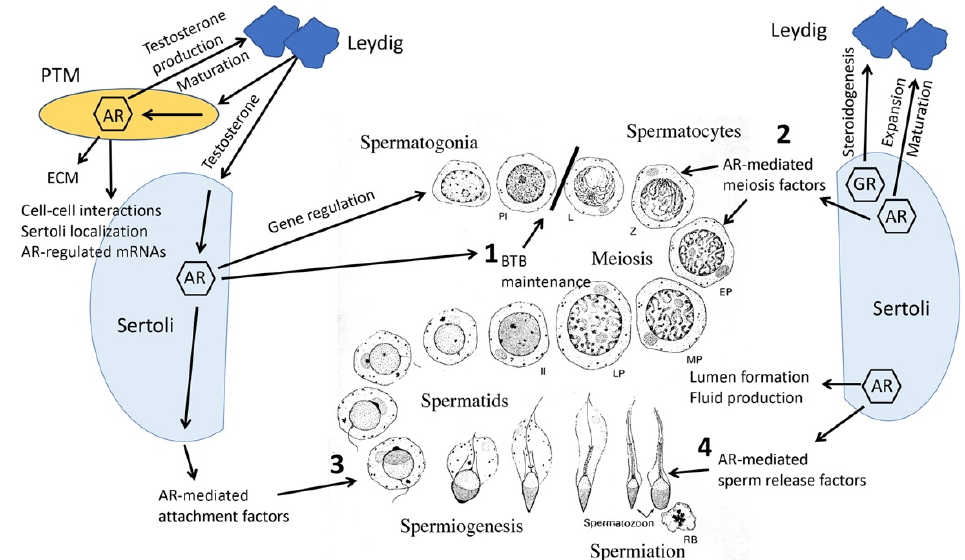
Figure 1. Steroid hormone-mediated signals between testicular cells maintain fertility. Androgen receptor (AR)-mediated actions in Sertoli cells support four major germ cells processes ( 1 – 4 ) required to maintain fertility. AR and glucocorticoid receptor (GR) in Sertoli cells support expansion and maturation of Leydig cells and steroidogenesis. Leydig cells produce testosterone that stimulates AR-mediated processes in Sertoli and peritubular myoid (PTM) cells. AR-dependent actions in PTM cells support the maturation of Leydig cells and their steroidogenesis as well as production of extracellular matrix (ECM), cell–cell interactions, Sertoli localization (positioning on the basement membrane) and AR-mediated mRNA expression in Sertoli cells. BTB, blood–testis barrier, PL, preleptotene; L, leptotene; Z, zygotene; EP, MP, LP; early, mid, late pachytene; II, meiosis II; RB, residual body.